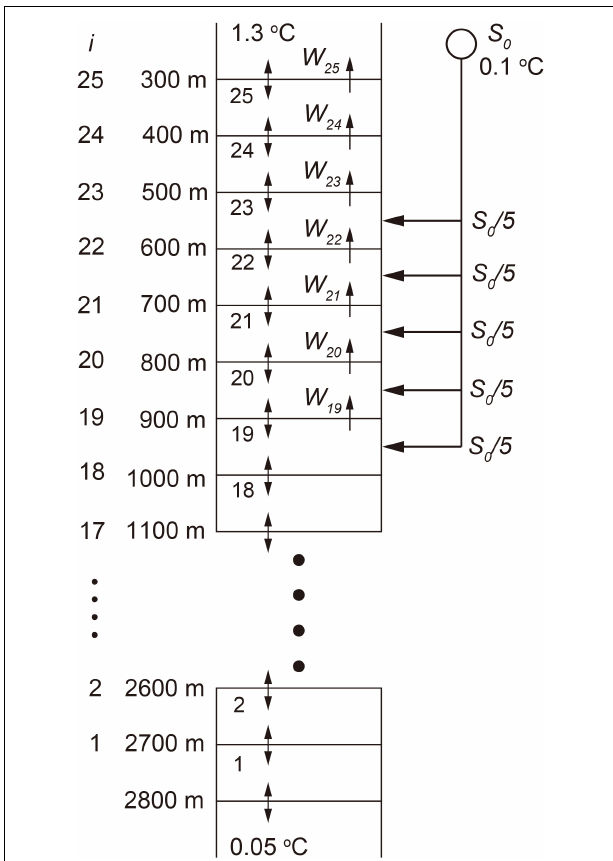
FIGURE 10 | Configuration of the vertical advection-diffusion box model which consists of 25 boxes with 100 m thickness. The horizontal advection of cold UJSPW (PT = 0.1 ◦ C) of volume S 0 from its souse region is represented by the water injection (ventilation) into the intermediate layers (boxes 19–23), which induces the upwelling velocity W 19 –W 25 . The two way arrows between the boxes indicate the vertical heat diffusion. The upper and lower boundary conditions are PT = 1.3 and 0.05 ◦ C,